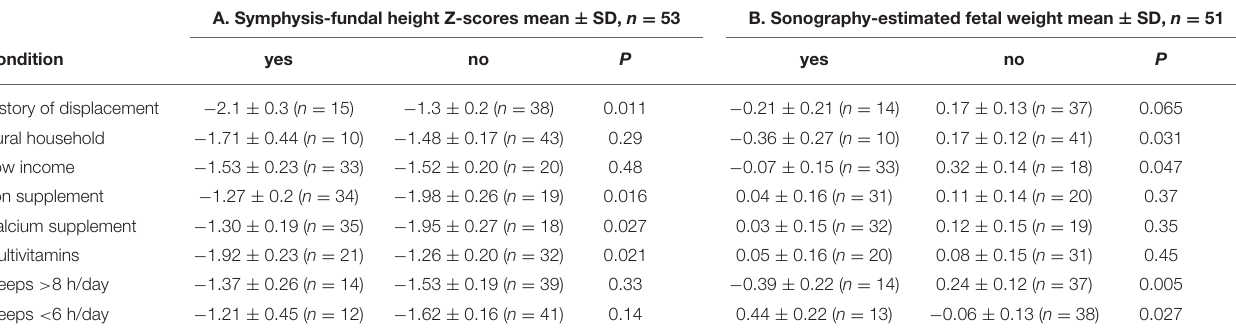
TABLE 4 | Comparisons of symphysis-fundal height (SFH) Z-scores and sonography-estimated fetal weight Z-scores by binary maternal variables. A. Symphysis-fundal height Z-scores mean ± SD, n =